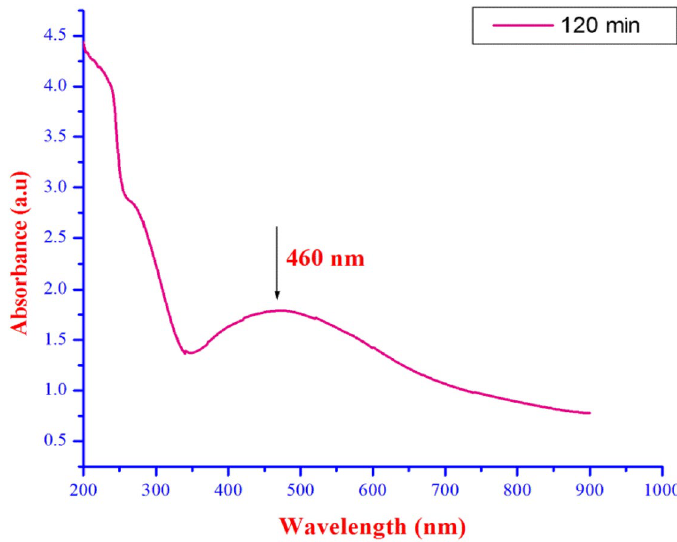
Figure 2. UV-vis spectra of the sardine fish scales fabricated AgNPs at 120 mins.